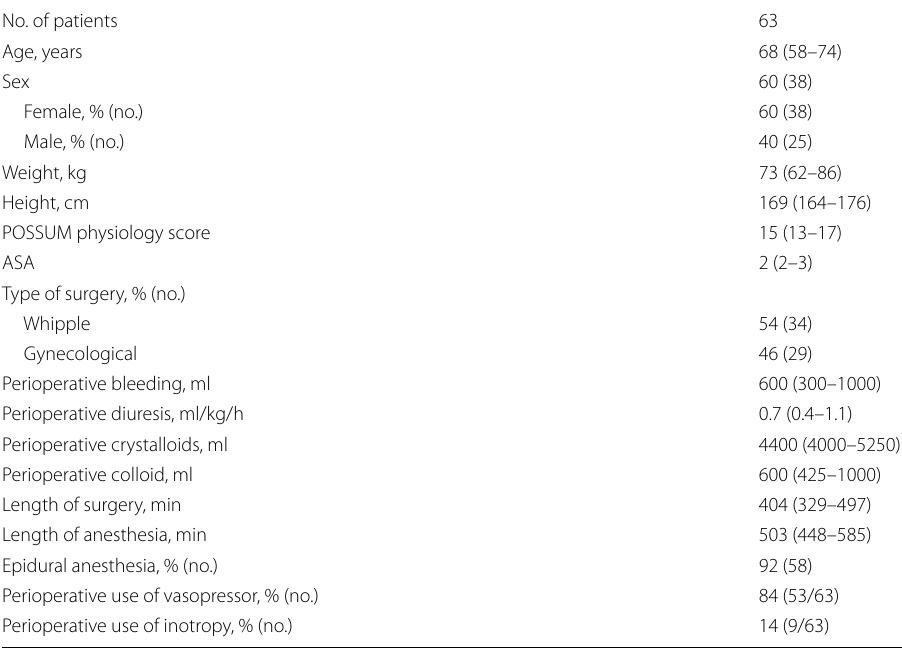
ASA, American Society of Anesthesiologists physical status; POSSUM, Physiological and Operative Severity Score for the enUmeration of Mortality and morbidity Data presented as median (IQR) or percentage (no.)